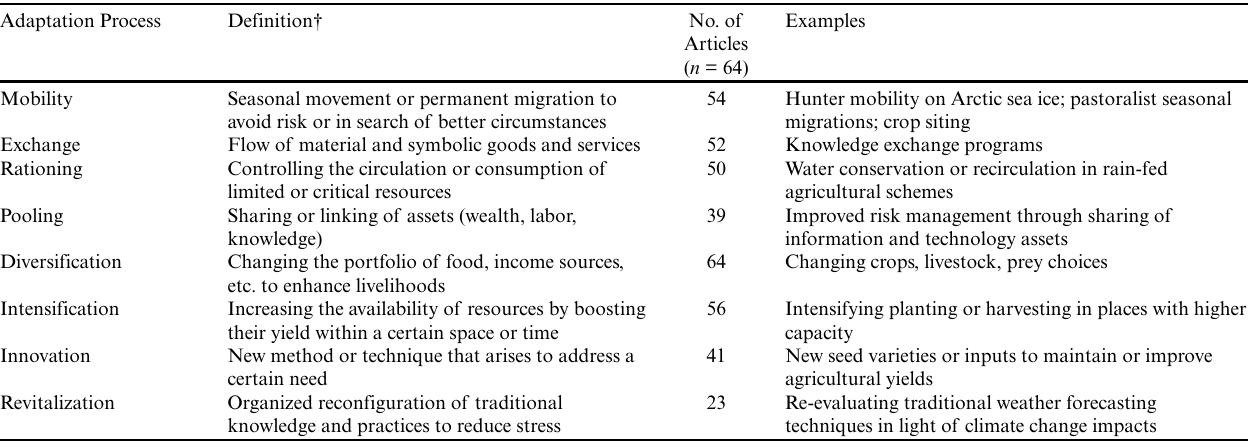
Table 4 . Adaptation processes addressed in the reviewed